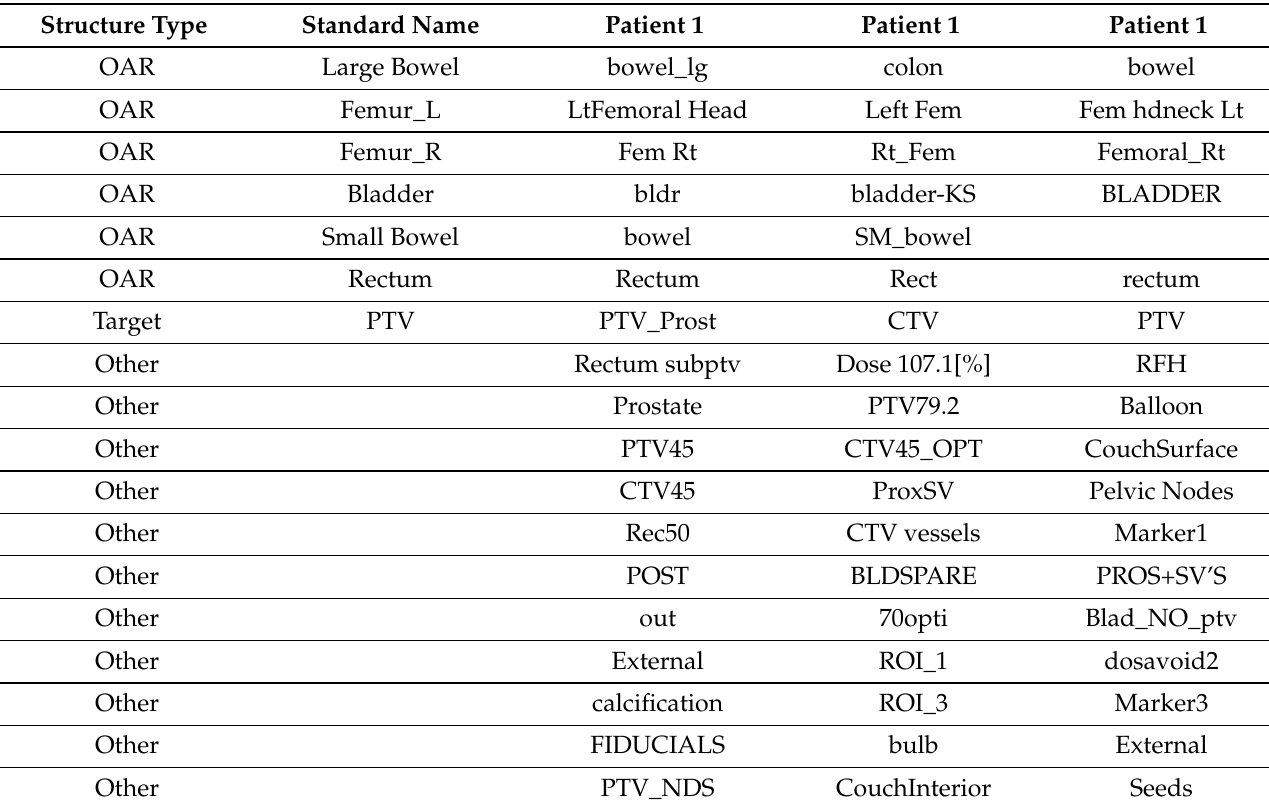
Table 1. Examples of physician-given structures’ names. OARs, Organs-At-Risk. Structure names in Patient_1, Patient_2, and Patient_3 show the variability in naming practices for